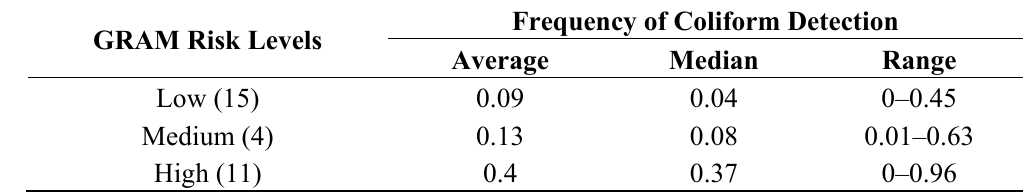
Table 5. GRAM risk levels and frequency of coliform detection for 30 groundwater systems; Number of systems in each category is given in